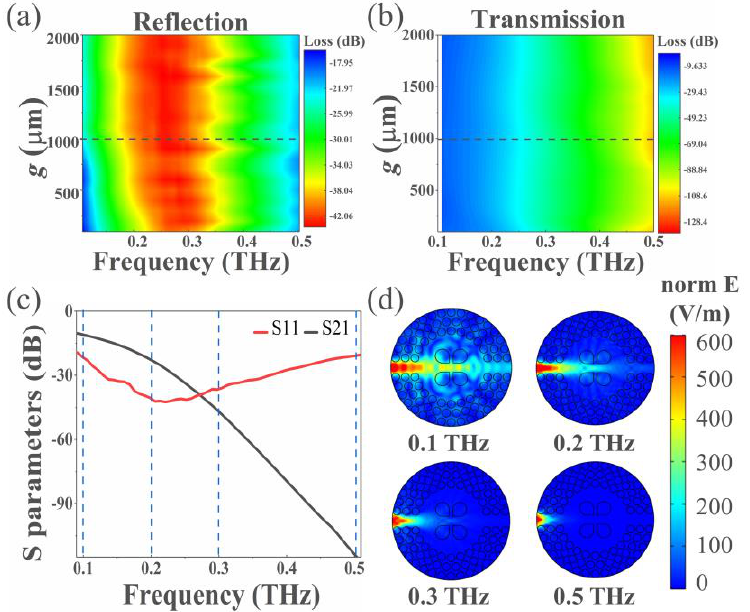
Figure 2. ( a , b ) The 2D contour maps of simulated reflection loss and transmission loss as a function of frequency with different gap distances ( g ), respectively. The black dashed line indicates g = 1000 µm. ( c ) The simulated S parameters of the THz PC waveguide with g = 1000 µm. These blue dashed lines indicate the frequency at 0.1 THz, 0.2 THz, 0.3 THz, and 0.5 THz, respectively. ( d ) Electric field distributions of the THz PC waveguide at g = 1000 µm with different frequencies (0.1 THz, 0.2 THz, 0.3 THz, 0.5 THz, respectively).